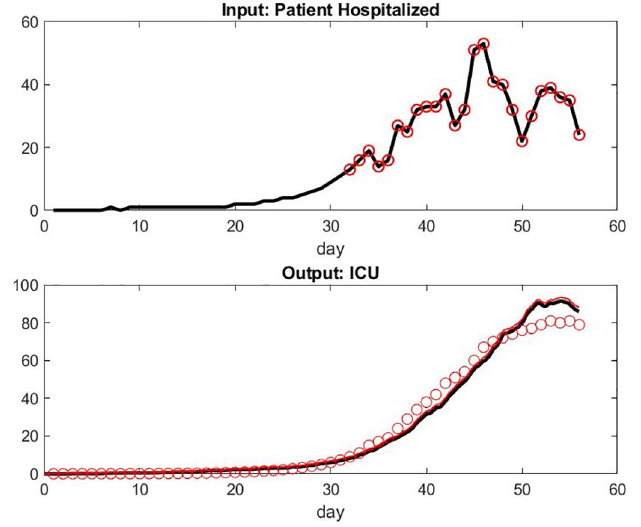
Fig 8. Top: Input of Patient Hospital Admission in Paris, France. Bottom: Model of Patient Under Mechanical Ventilation in ICU Versus Data Set.